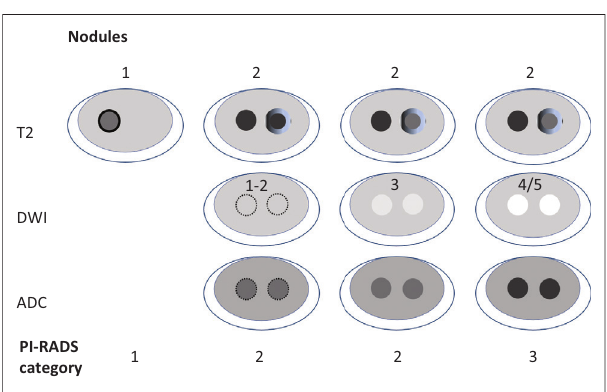
FIGURE 6: Schematic diagram of transition zone nodules, the corresponding T2-weighted imaging scores and description of acceptable variants. 10